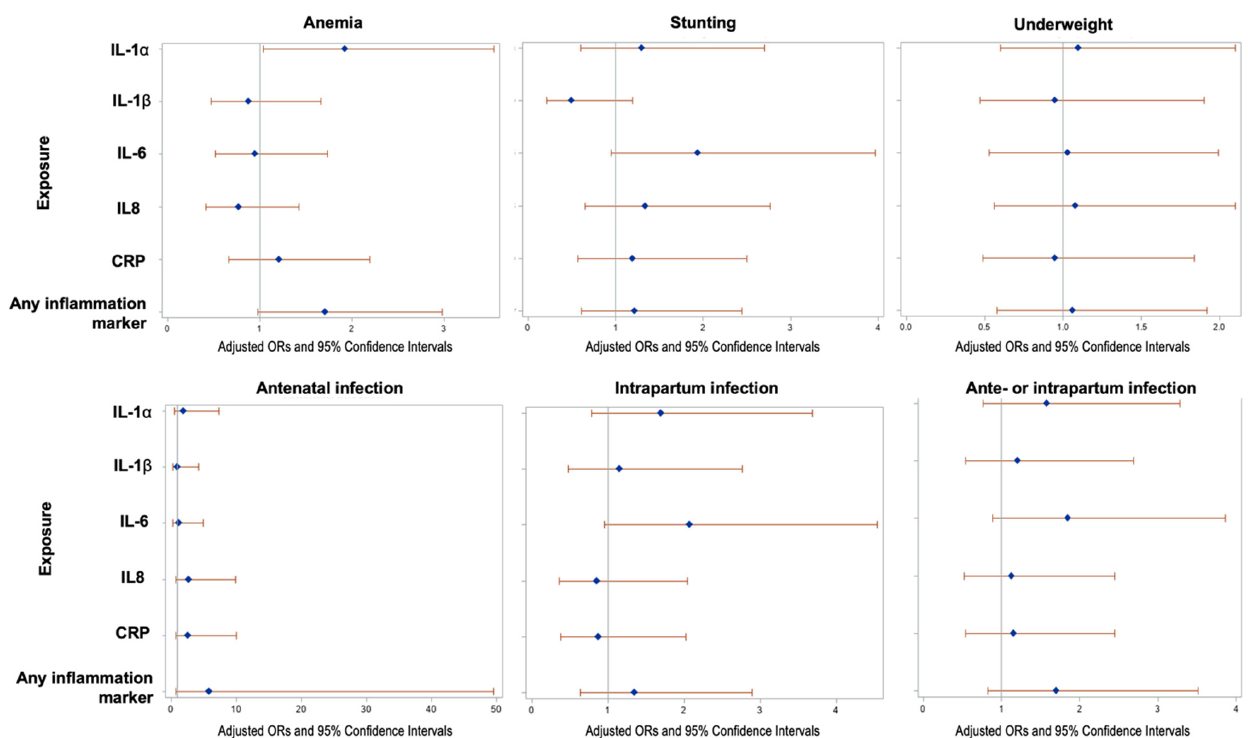
Figure 4. Association of maternal anthropometry and infections with newborn inflammation at delivery ( n = 251 healthy term infants): Odds ratios are for outcome of elevation in inflammation protein above the 75% (vs. <75%). The 75% thresholds for each cytokine are: IL-1 α : 0.05 pg/mg total protein; IL-1 β : 2.01 pg/mg total protein; IL-6: 0.0046 pg/mg total protein; IL-8: 3.09 pg/mg total protein; and CRP: 0.04 ng/mg total protein. Analyses were adjusted for potential confounding by socioeconomic status, nulliparity, maternal education attainment (years), maternal upper arm circumference (MUAC) < 22 cm, tobacco or betel nut use, and season of initial antenatal assessment.